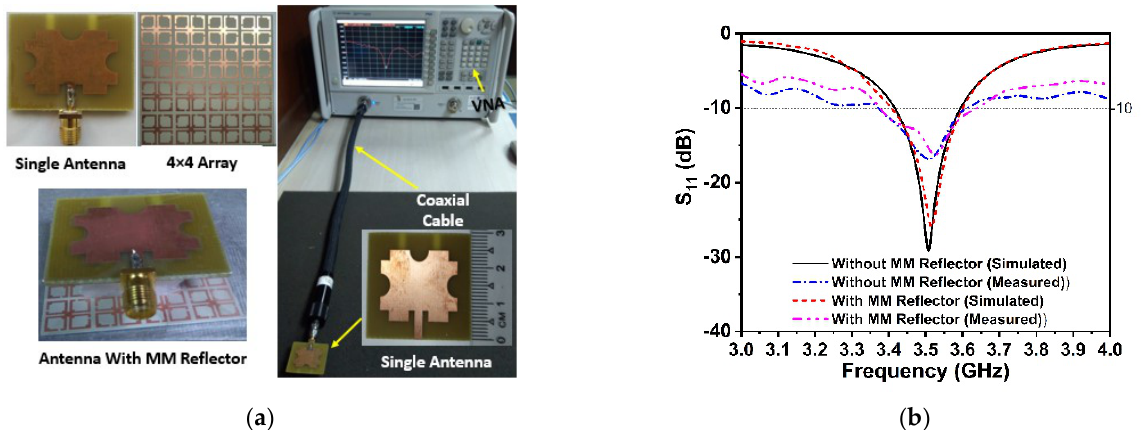
Figure 20. ( a ) VNA experimental arrangement with fabricated prototype. ( b ) Comparison of the S 11 experimental and CST-simulated performance of the proposed antenna with and without the MM reflector.